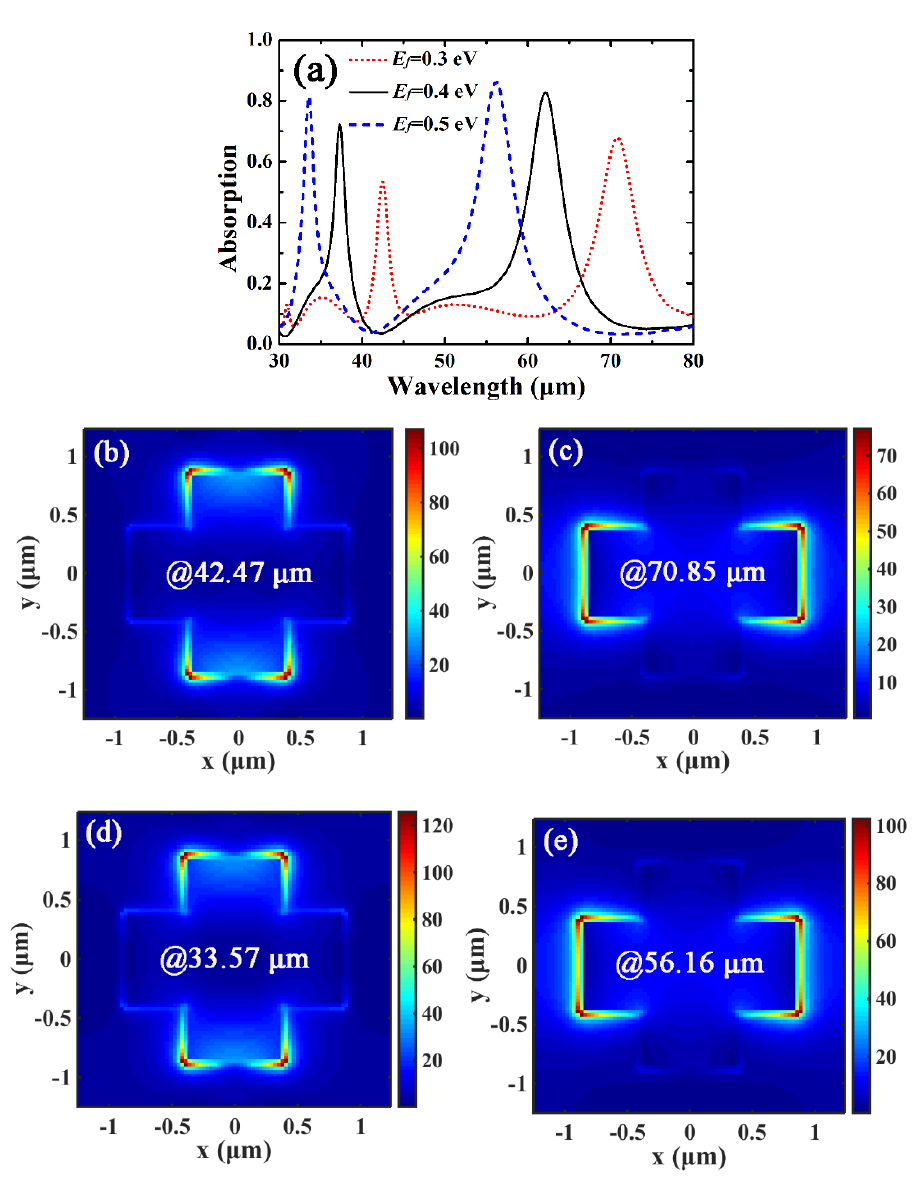
Figure 5. ( a ) Absorption spectra of the cross-shaped graphene arrays for di ff erent E f . ( b , c ) are the normalized electric-field distributions of the cross-arm with E f = 0.3 eV in the xy plane for absorption peaks of 42.47 µ m and 70.85 µ m, respectively. ( d , e ) are the normalized electric-field distributions of the cross-arm with E f = 0.5 eV in the xy plane for absorption peaks of 33.57 µ m and 56.16 µ m, respectively.